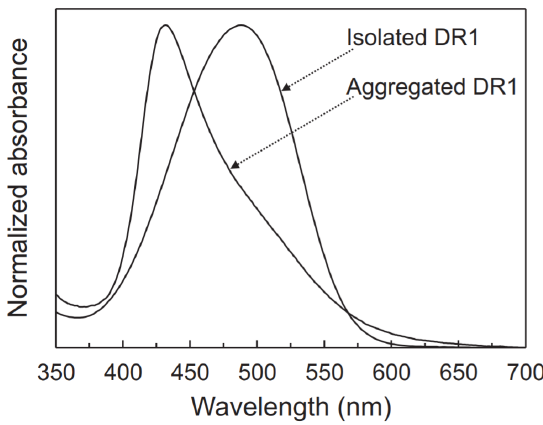
Figure 7. Normalized absorption spectra of isolated (measured from dilute THF solution) and aggregated (measured from DR1-doped polystyrene matrix) DR1 molecules [71].